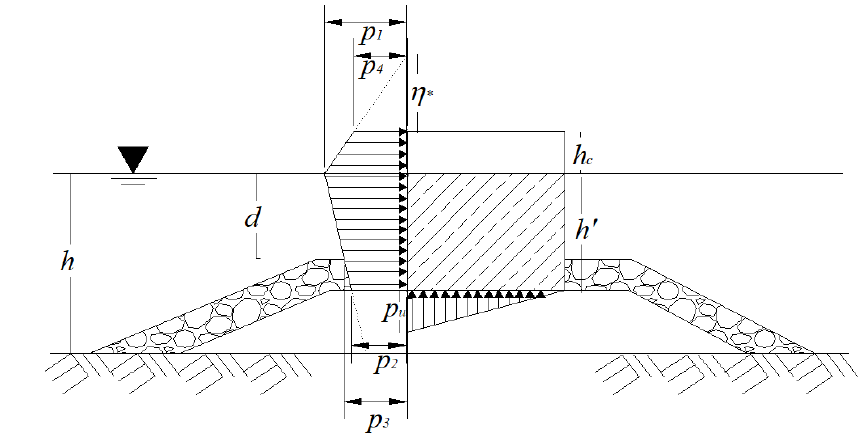
Figure 5. Distribution of wave pressure on an upright section of a vertical breakwater according to the model of Goda (from Goda, 2010). Values are referred to the